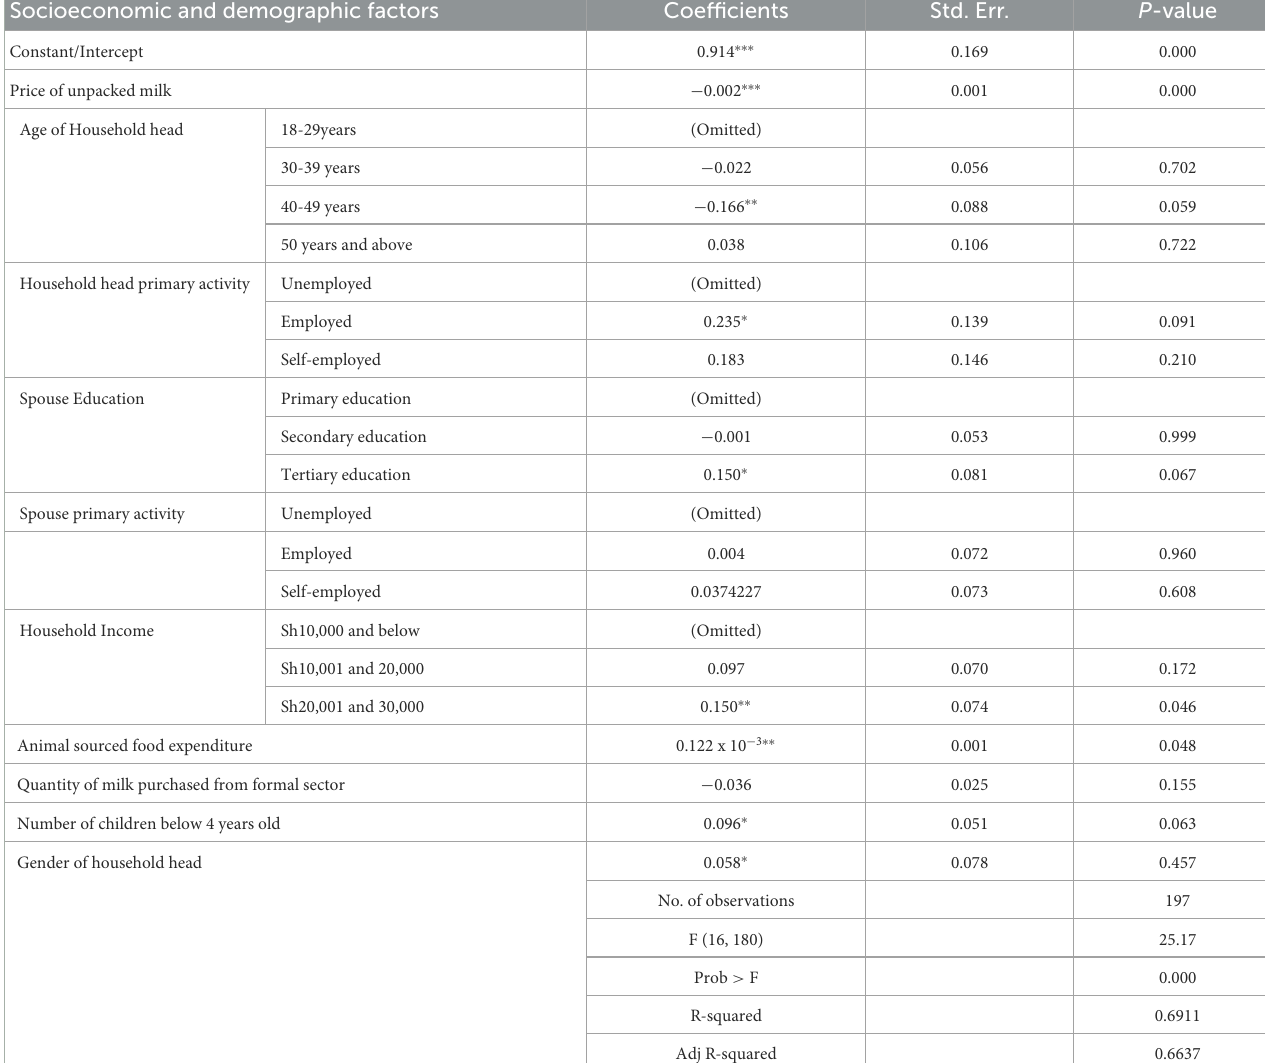
TABLE 4 OLS estimations of determinants of amount of milk purchased form the informal market. Socioeconomic and demographic